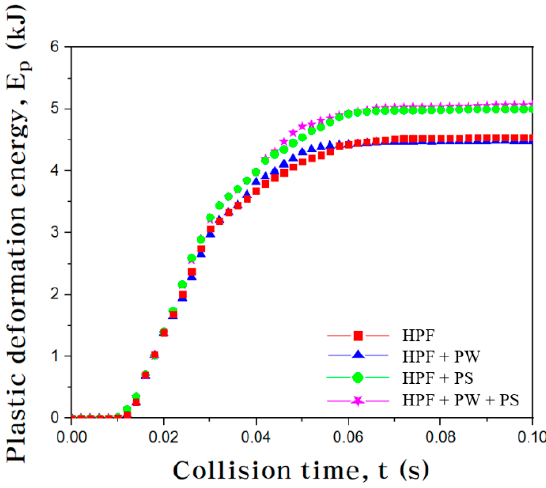
Figure 14. Plastic deformation energy ( E p ) of the four kinds of the center pillar during side crash.